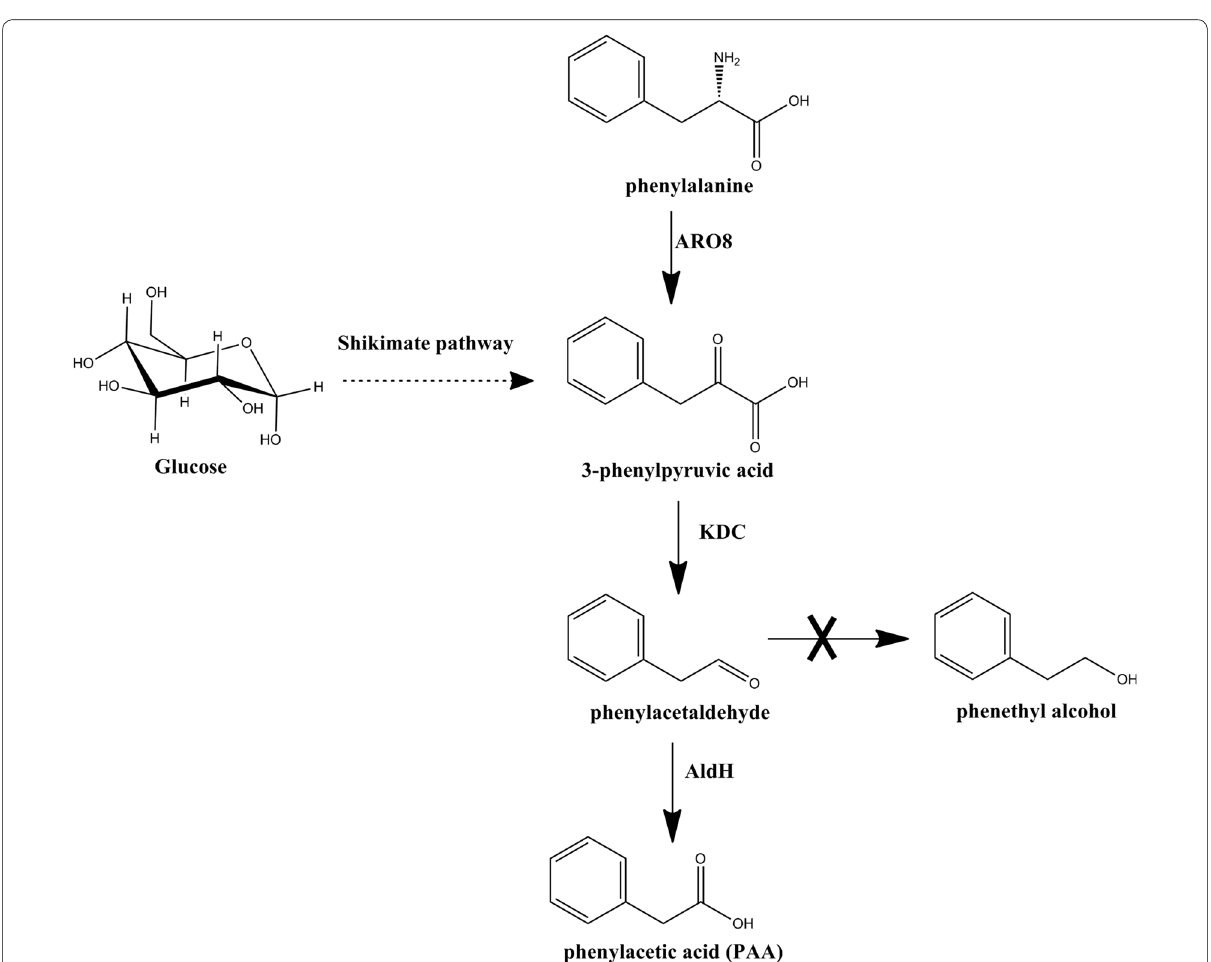
Fig. 1 The phenylacetic acid (PAA) biosynthesis pathway used in this